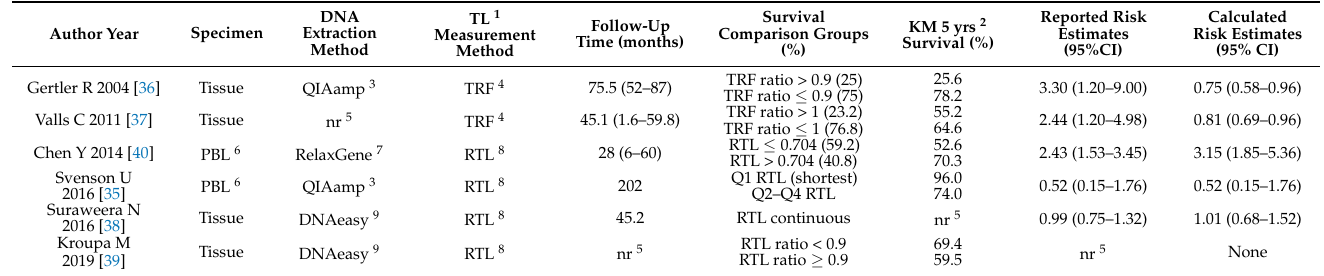
Table 3. Characteristics of telomere length measurements in peripheral blood leukocytes or tumor tissue of n = 6 studies and the reported survival estimates compared with the calculated estimates (1st quartile vs. the longer quartiles